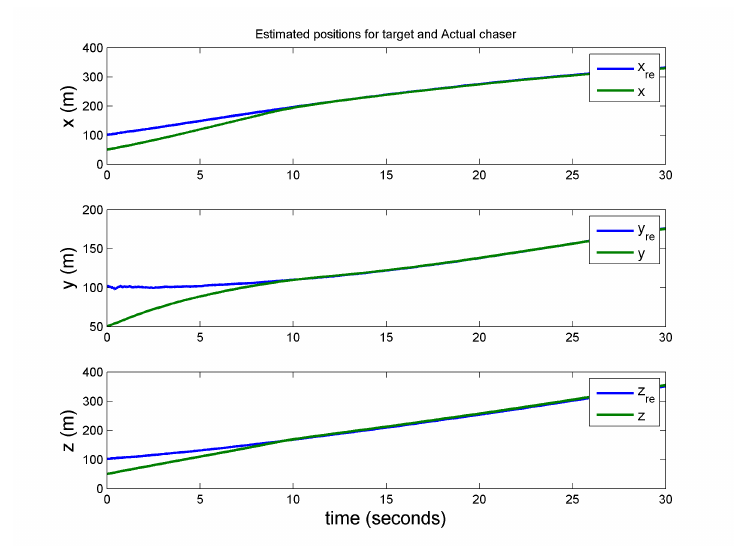
Figure 24. Estimated target and chaser position (Case 3).